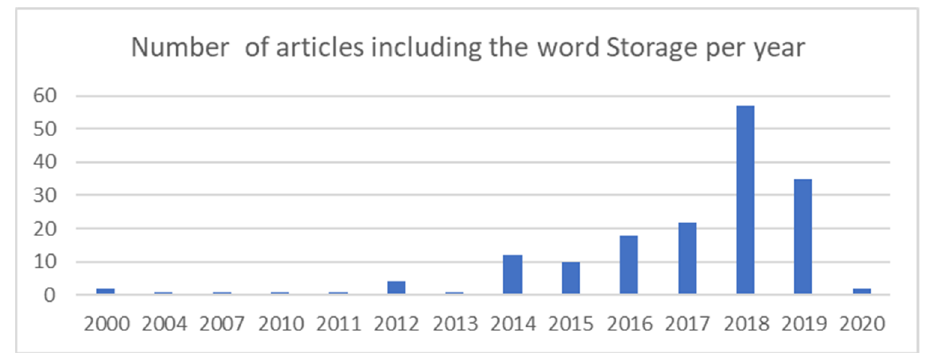
Figure 18. The appearance of the word “storage” in the abstracts, titles or keywords among the 899 articles (the total population of articles). Appearance per year (horizontal axis) and the number of articles (vertical axis).